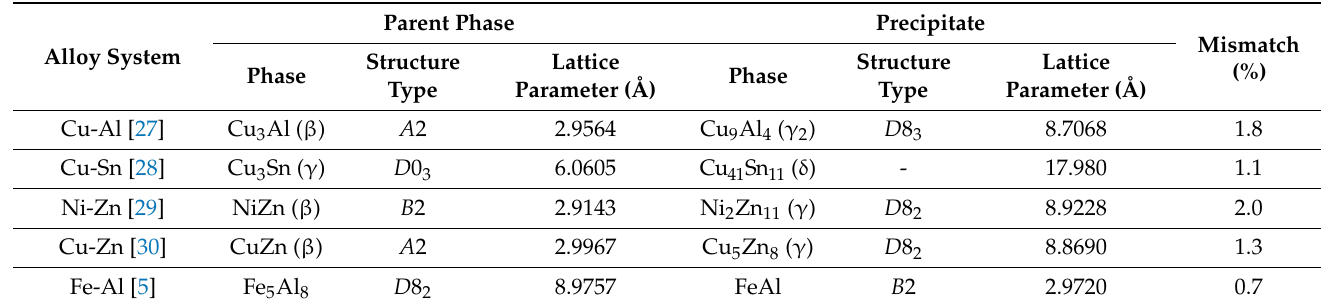
Table 1. Crystallographic features of the parent phase and the precipitate in binary alloys in which dendritic morphology is confirmed [16] compared with the present Fe-Al phases (last